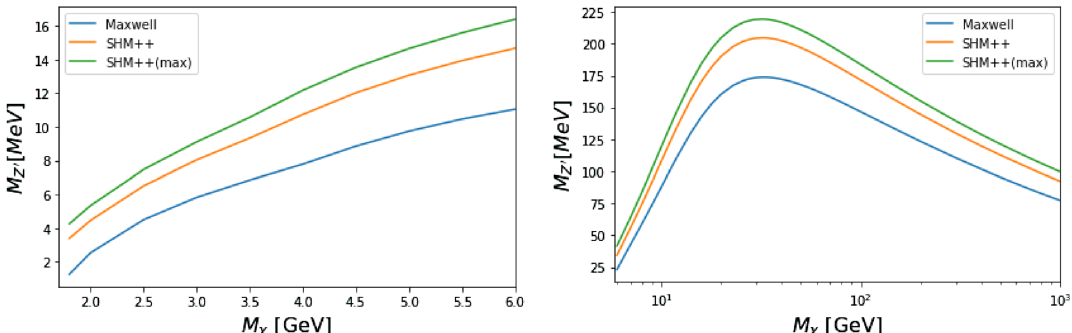
Fig. 13 Impact of the velocity distribution on exclusion for the Z’ model with vector couplings from DarkSide-50 (left) and XENON1T (right) in the M Z (cid:2) − M χ plane. Here g Z (cid:2) = 1 × 10 − 7 , g χ = 5 . 5 × 10 − 5 . The exclusion obtained with the Maxwell distribution and standard